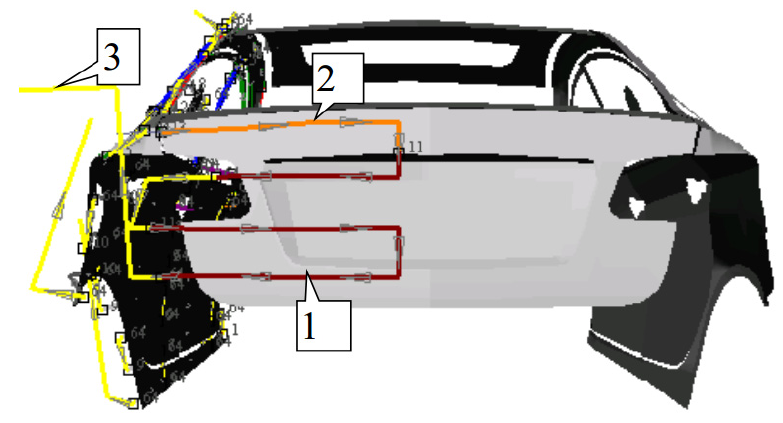
Figure 11. Optimized trajectory of the rear.